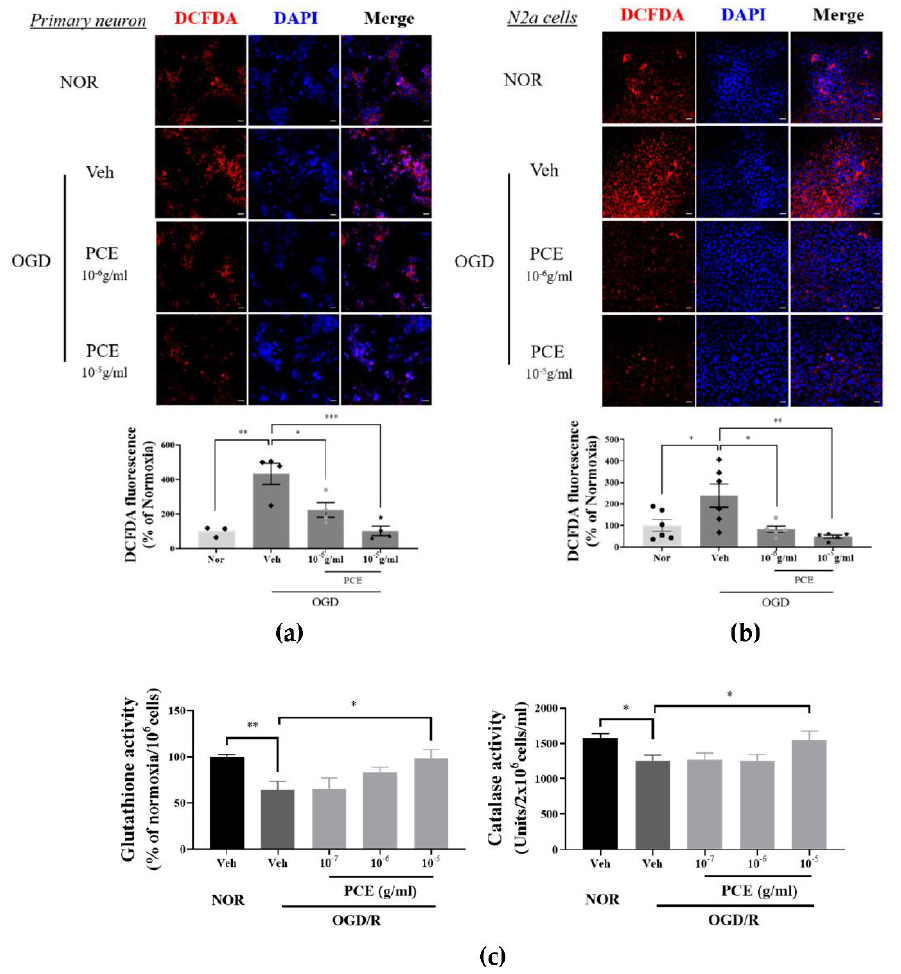
Figure 3. Antioxidant properties of PCE in OGD-induced neuronal cells. ( a , b ) Representative immunofluorescence images of DCFDA (red) staining showing superoxide levels in neuronal cells exposed to 2 h OGD/0.5 h R and 4 h OGD/0.5 h R in primary cortical neuronal cells and N2a cells, respectively. Primary cortical neuronal cells were treated with two concentrations of PCE (10 −6 and 10 −5 g/mL) before OGD/R. PCE inhibited ROS production in OGD/R-exposed neuronal cells. ( c ) Estimation of GSH and CAT enzyme activities in N2a cells exposed to 4 h OGD/24 h R. The antioxidant enzyme activities were decreased after OGD/R insult in N2a cells, whereas PCE increased its GSH and CAT activities as compared to the vehicle treatment in OGD/R-exposed N2a cells. The mean values in triplicate experiments are presented as SEM. White scale bar = 20 µ m. *** p < 0.001, ** p < 0.01, * p < 0.05, determined by Student’s t -test for homogeneous variance and one-way ANOVA, followed by Tukey’s multiple comparison test (N2a, n = 7, primary neuron, n = 4).